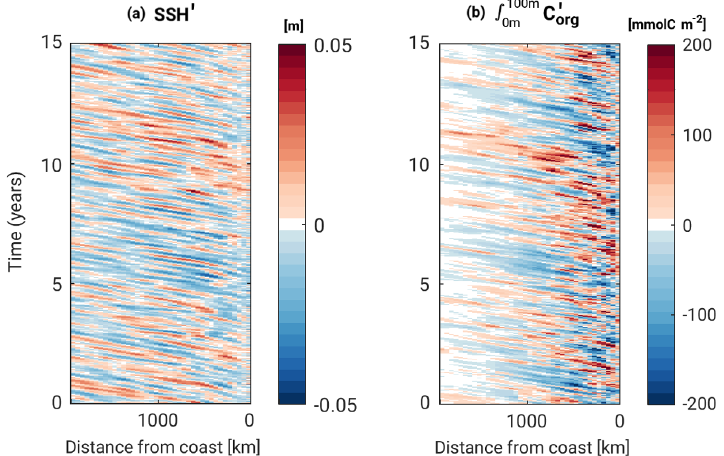
Figure B7. Hovmoeller diagram of the turbulent SSH anomalies (SSH (cid:48) ) and top 100m organic carbon stock C org ( R 100m central subregion of the CanUS. First 15 years of analysis data, bi-daily output. Their signature shows remarkable interannual variability despite the climatological forcing used for our simulation, highlighting the intrinsic nature of turbulence and variability in the